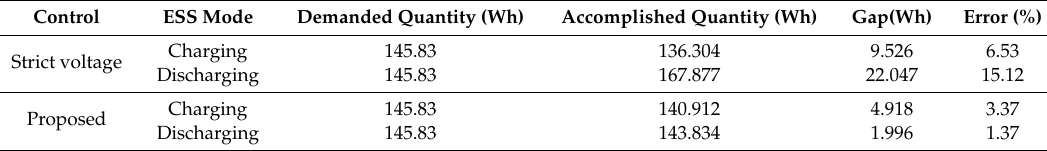
Table 3. Numerical results for imposed order and profiled quantity.